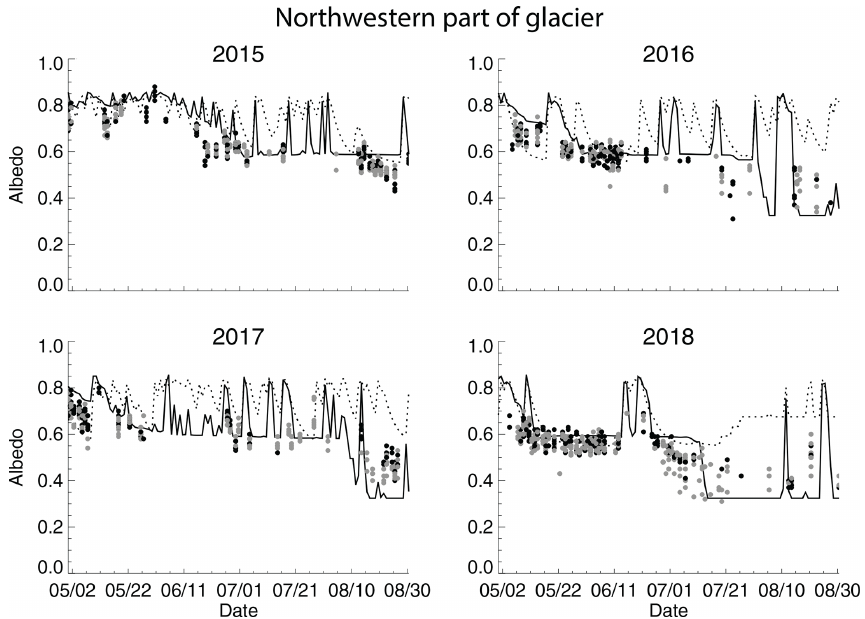
Figure 15. Same as Fig. 14 but at a northwestern part of Hardangerjøkulen, where snow completely melts to the ice surface at